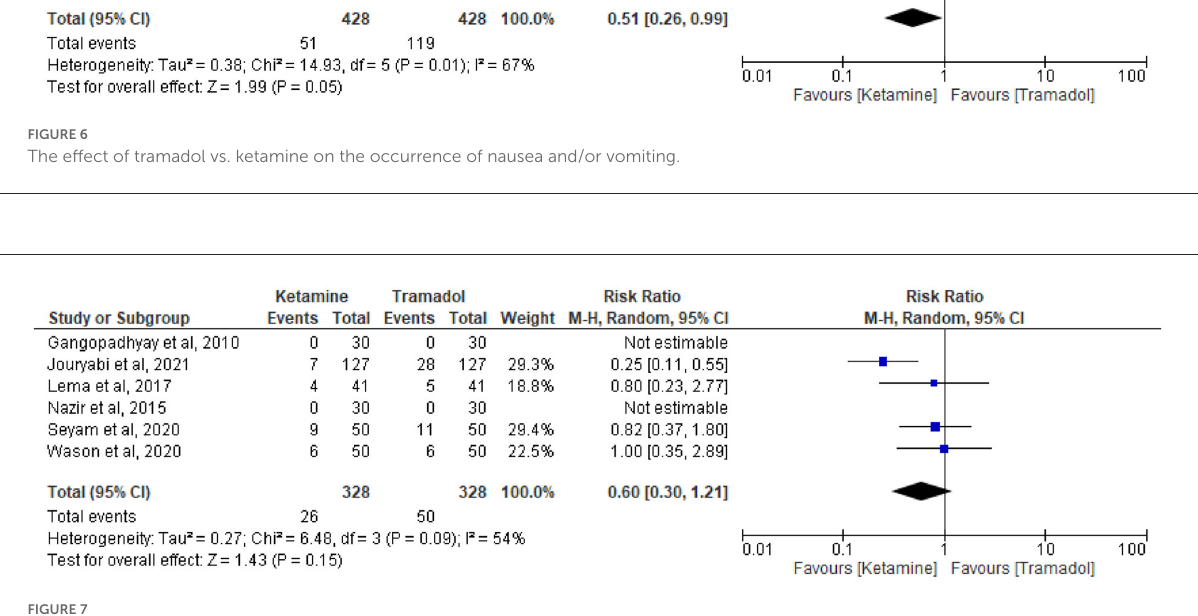
FIGURE7 The effect of tramadol vs. ketamine on the incidence of